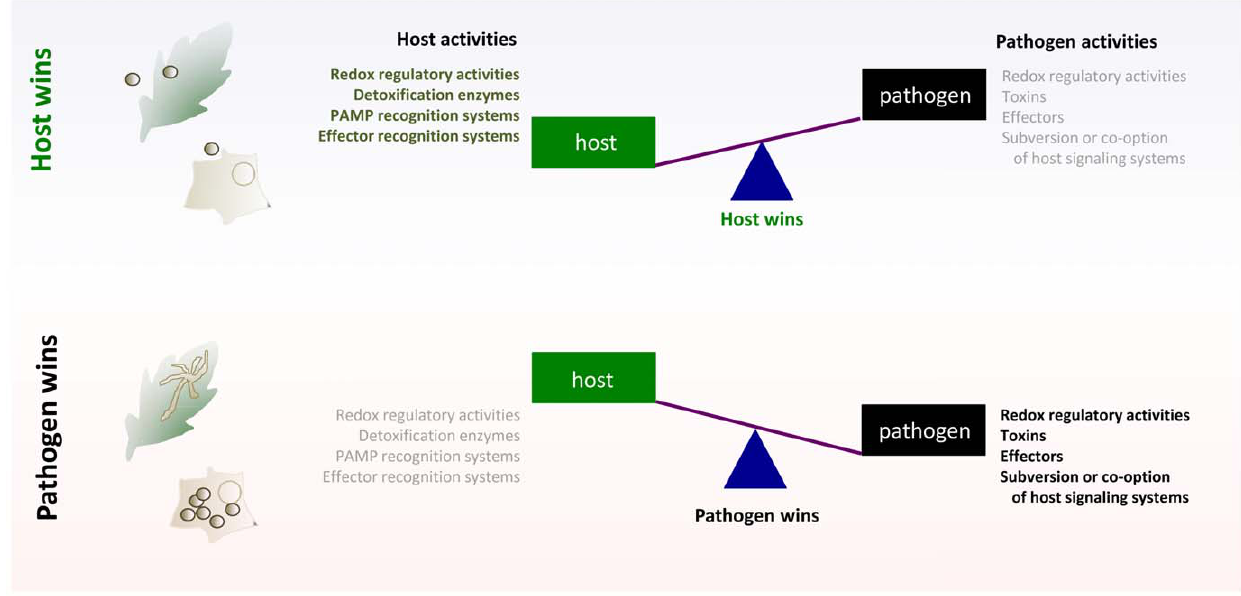
Figure 1. Tipping the balance for control in host–pathogen interactions; generalized schematic. To become established in plants or animals, fungal pathogens attempt to disrupt host cell homeostasis while avoiding and/or suppressing host recognition. The host has sophisticated surveillance systems that are poised to rapidly recognize non-self and counter disruptive attempts by pathogens. Signals activated by these surveillance systems can initiate a myriad of host defenses, including the release of reactive oxygen species and hydrolytic enzymes, which thwart the activities of fungal pathogens. The activation of host defense mechanisms also often culminates in the programmed death of host cells or tissue, which limits pathogen spread or dissemination. If attempts by the pathogen to co-opt, subvert, or avoid these host recognition and signaling mechanisms succeed, then the pathogen ‘‘wins’’ the battle for control of the interaction, and disease ensues. If the host wins this battle, then disease is averted.